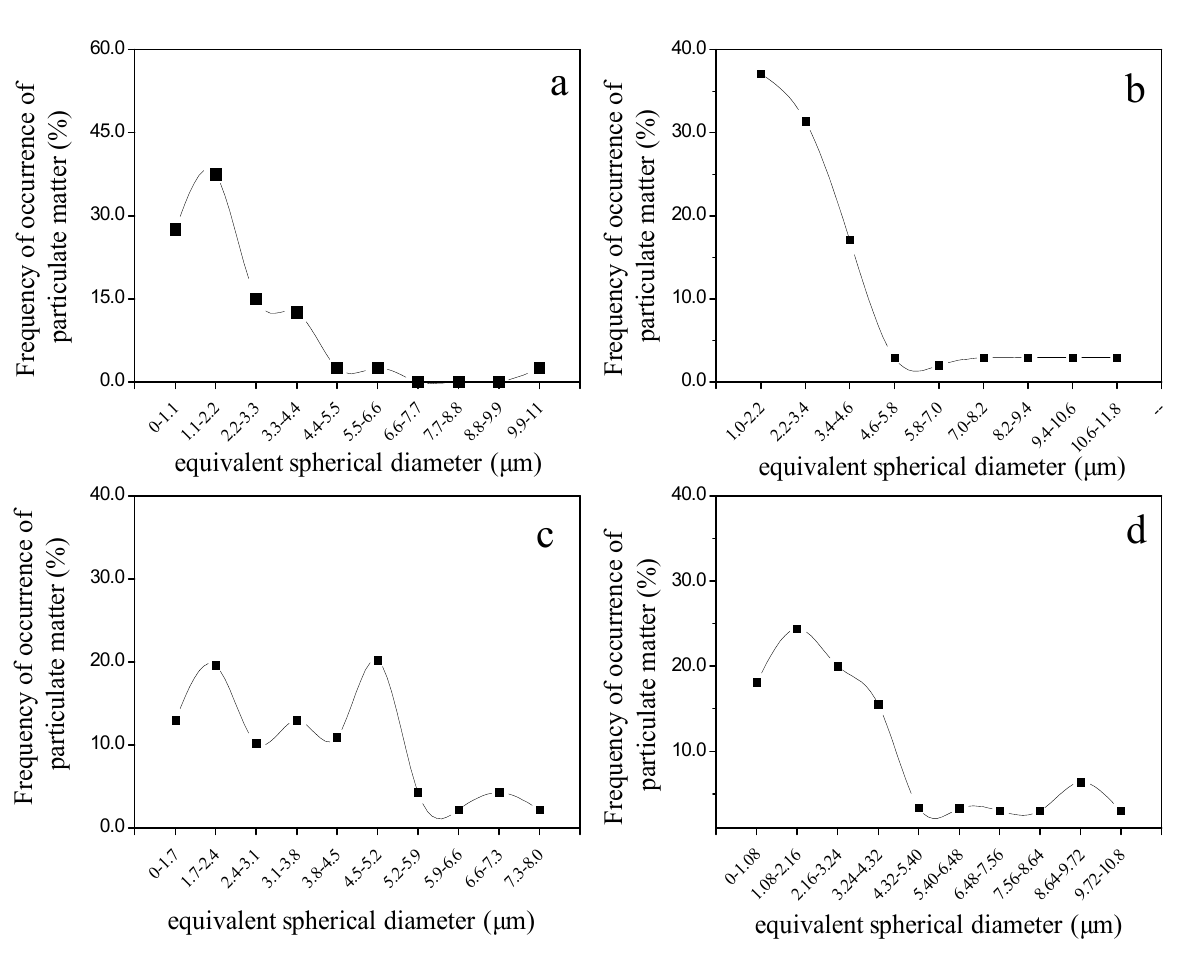
Figure 3. Equivalent spherical diameter distribution of atmospheric fine particles in the four different areas at Mount Wutai, Shanxi, China. (( a ) Sampling points in the Wu Ye Temple; ( b ) sampling points in the Manjusri Temple; ( c ) sampling points in the Yang Bai Lin Village; ( d ) sampling points in the Nan Shan Temple Forest